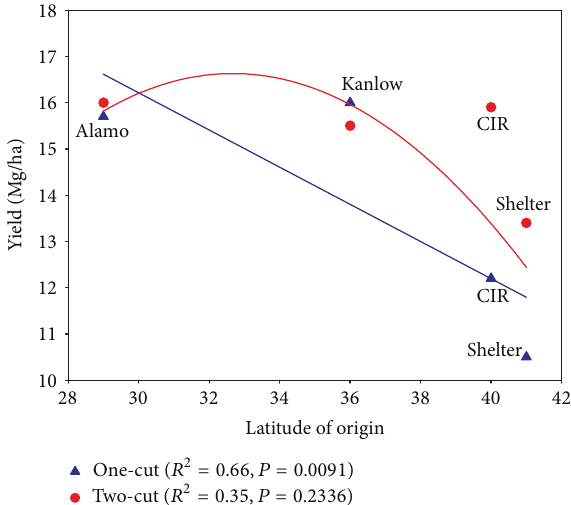
Figure 1: Relationship between latitude of origin and yield of four switchgrass cultivars grown under two management systems in the upper southeast USA. The one-cut management included 50 kg Nha/yr, and the two-cut management involved applying 100kg N/ha/yr. Yield data are the means for each cultivar averaged across sites and years from Table 4.